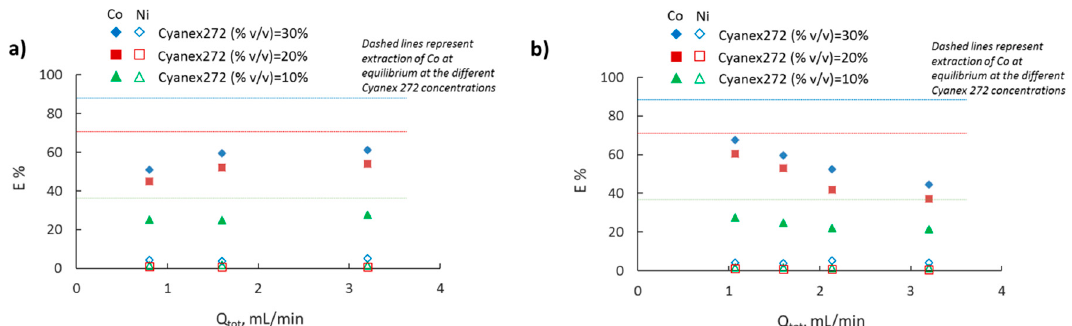
Figure 9. Extraction percentage of Co(II) and Ni(II) in the 2 mm channel as a function of total flowrate (Q tot ) at different Cyanex 272 concentrations ( a ) at constant residence time (t = 20 s), and ( b ) at constant reactor length (L r = 17 cm).